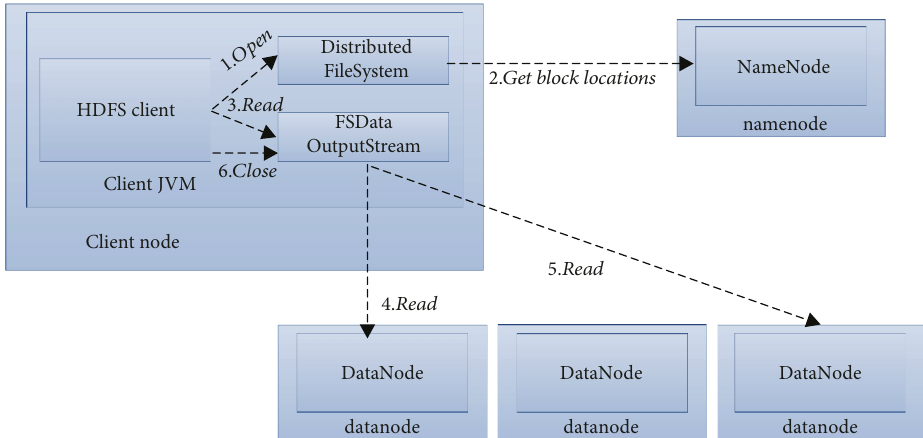
Figure 2: Reading